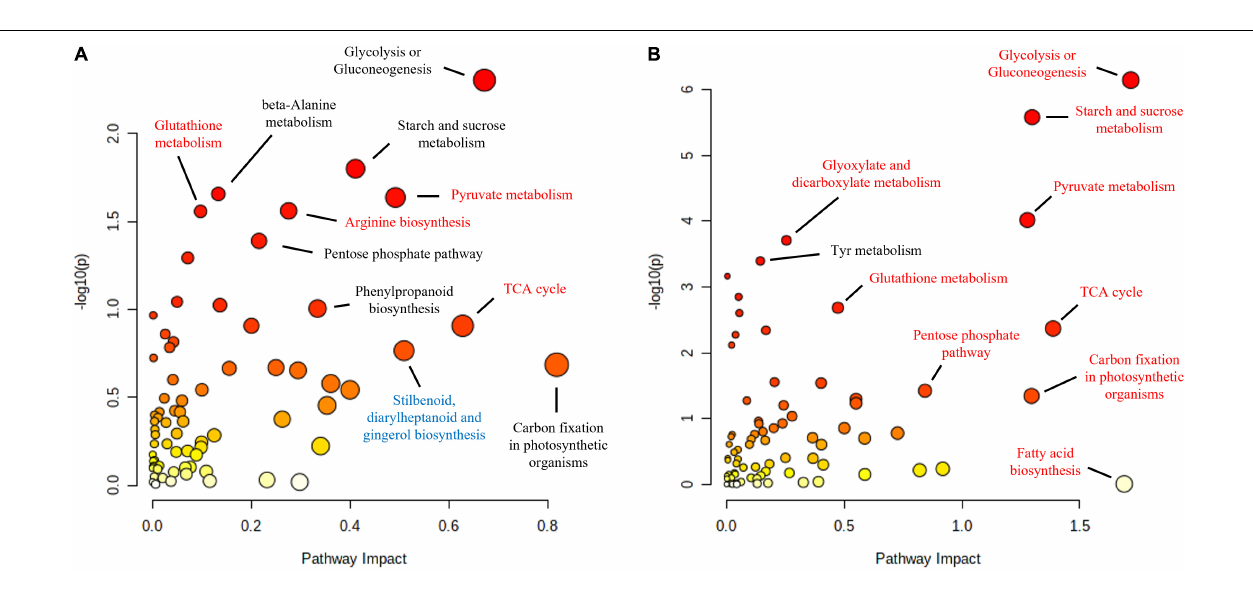
FIGURE 11 | Functional enrichment and pathway topology analysis of the metabolites and proteins affected in the leaves of Q. suber (A) and Q. variabilis (B) 16 h after inoculation with P cinnamomi . Molecular pathways highlighted in red and blue contained a higher number of proteins and metabolites with increased and decreased abundance, respectively. The color of each point corresponds to its p -value (yellow to red) and its size is calculated based on the pathway impact